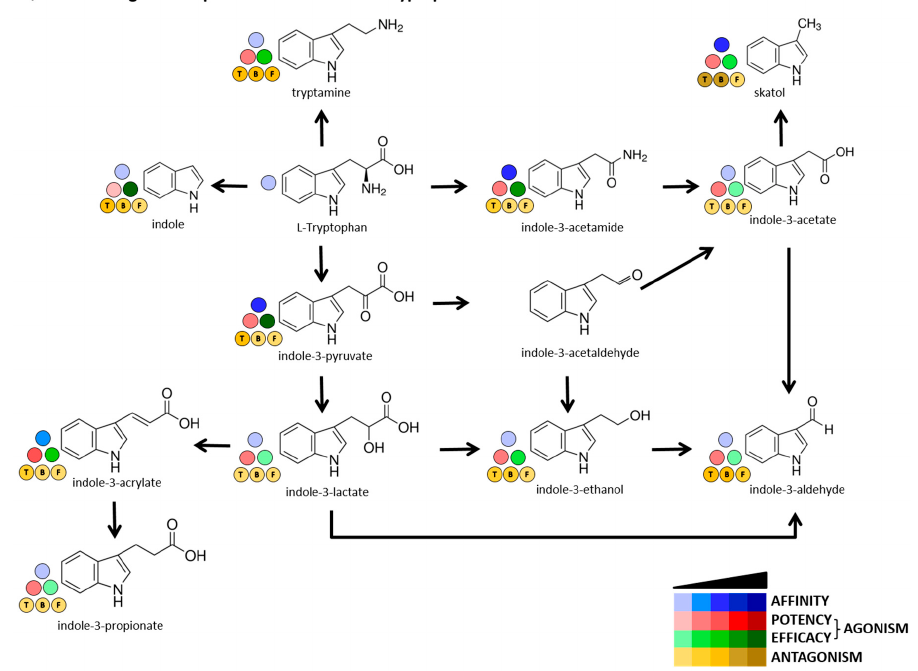
Figure 3. Quantitative characterization of interactions between MICT and AhR. A scheme depicts intestinal microbial catabolism of tryptophan, and the source data come from Figure 1 and Figure 2. The Blue scale refers to the affinity of MICT (ligand binding). The Red & Green scales quantify the relative agonist effects of MICT; Red ≈ potency (EC 50 ), Green ≈ efficacy (E MAX ). The Brown scale quantifies the relative antagonist effects (IC 50 ) of MICT against three different agonists used at EC 80 concentration and designated as “T” = TCDD, “B” = BaP, “F” = FICZ.